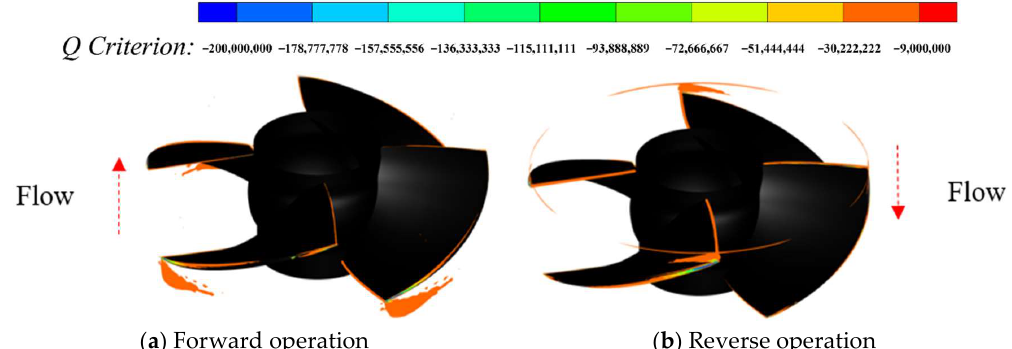
Figure 19. 0.9 Q d impeller internal vorticity distribution diagram.